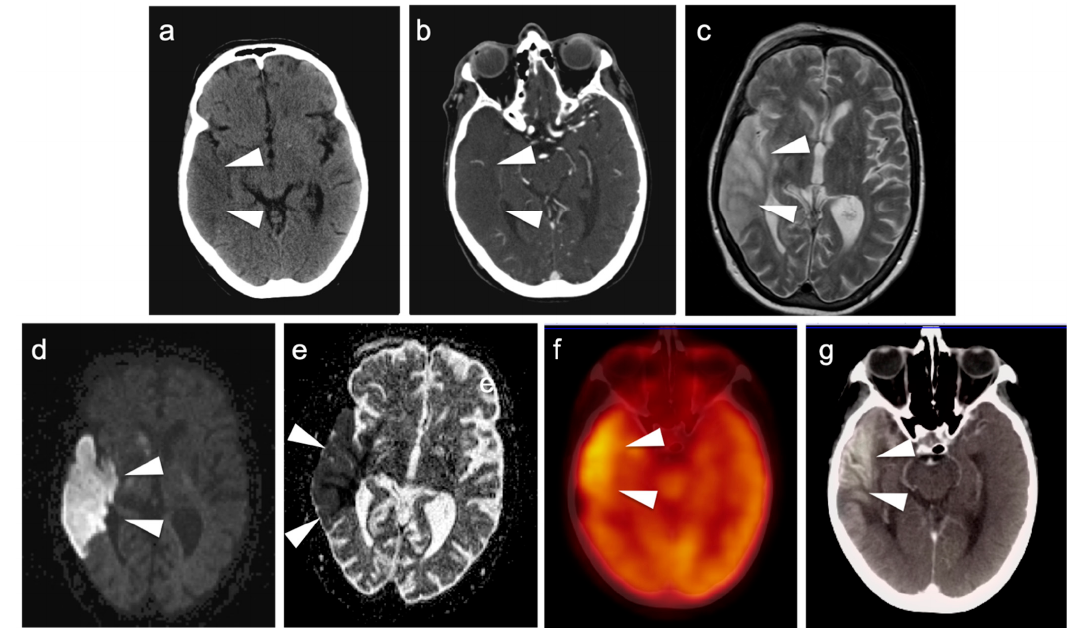
Figure 37. Subacute stroke with subacute increased uptake of FDG may mimic brain tumor. ( a ) Acute stroke with hypoattenuation in the right temporal lobe on con-contrast-enhanced CT (white ar- rowheads). ( b ) Acute stroke on contrast-enhanced CT with decreased vascularity in area of right temporal lobe infarction (white arrowheads). ( c ) T2 MRI in acute stroke showing increased signal in right temporal lobe due to edema (white arrowheads). ( d ) Diffusion weighted MRI (DWI) image shows increased signal in area of the right temporal stroke in the same patient (white arrowheads). ( e ) Apparent diffusion coefficient (ADC) MRI map shows a corresponding area of decreased signal in the right temporal lobe in the same patient (white arrowheads). ( f , g ) FDG PET-CT scan in a subacute stroke (2 weeks after presentation, performed because of co-existing vulvar carcinoma) shows increased metabolic activity coinciding with the region of CT high-attenuation pseudolaminar necrosis in the right temporal lobe (white